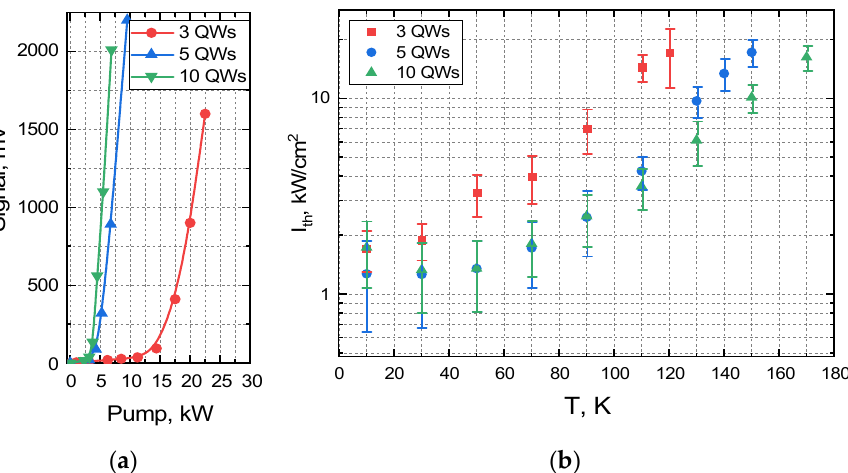
Figure 2. ( a ) Dependence of photoluminescence signal on pumping power at T = 110 K, ( b ) Threshold pumping intensity (I th ) under pulsed pumping (1.5 μ m wavelength, 10 ns pulse duration, 10 Hz repetition rate) for different temperatures (T). 3, 5, 10 QWs—number of quantum wells in the structure.